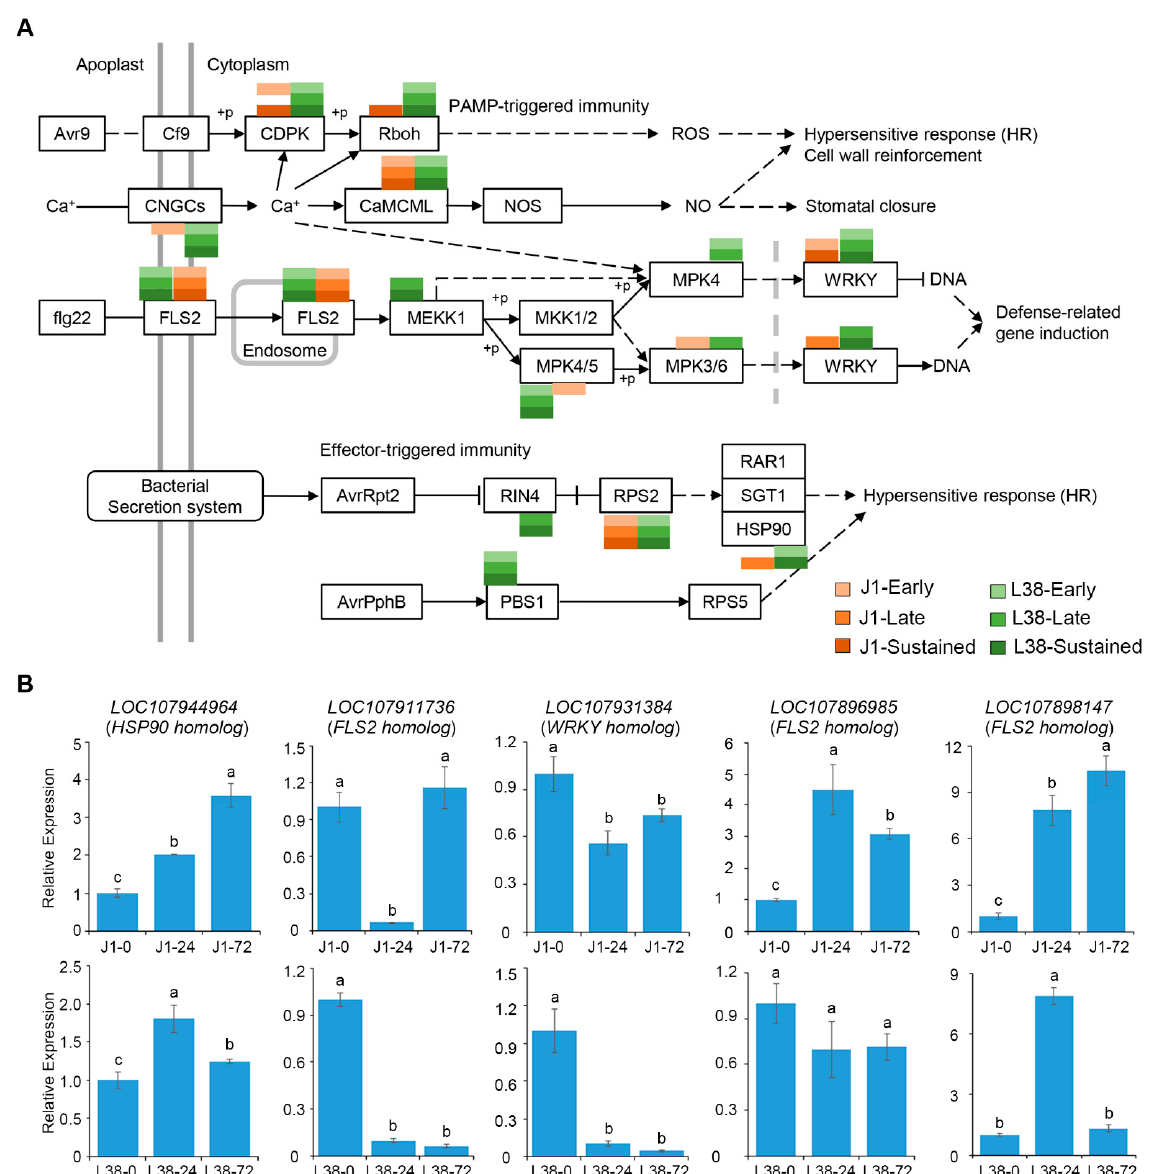
Figure 4. DEGs were assigned in plant-pathogen interaction. ( A ) Demonstration of enrichment of DEGs in plant-pathogen interaction with p -value < 0.05. ( B ) RT-qPCR analysis of expression pattern of specific DEGs of J1 and L38 assigned to plant-pathogen interaction cluster. Relative expression levels were normalized by cotton 18S gene expression level. The relative gene expression level in J1-0 and L38-0 were assigned a value of 1.0. Error bars indicate ±SD of three biological replicates, with each measured in triplicate. Samples marked with different letters show a significant difference at p < 0.05 by Duncan’s multiple range test.